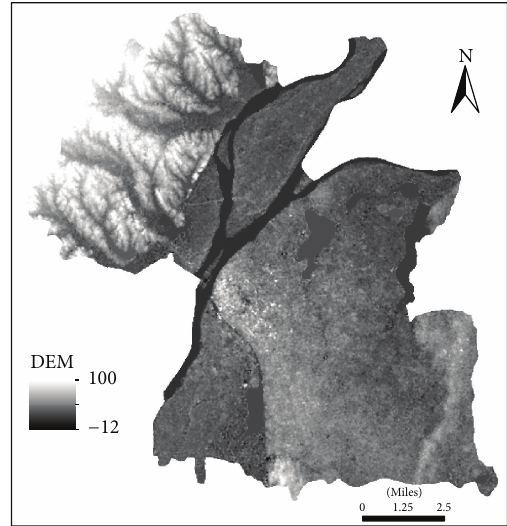
Figure 4: Digital elevation data modeled as 30-meter resolution SRTM.